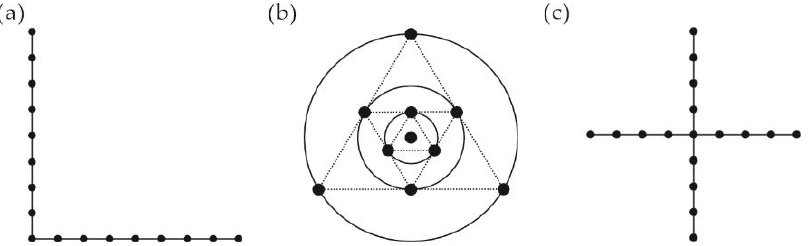
Figure 2. Micro-movement irregular observation array: ( a ) L-shaped array; ( b ) triangular array; and ( c ) cross array. ( c ) cross